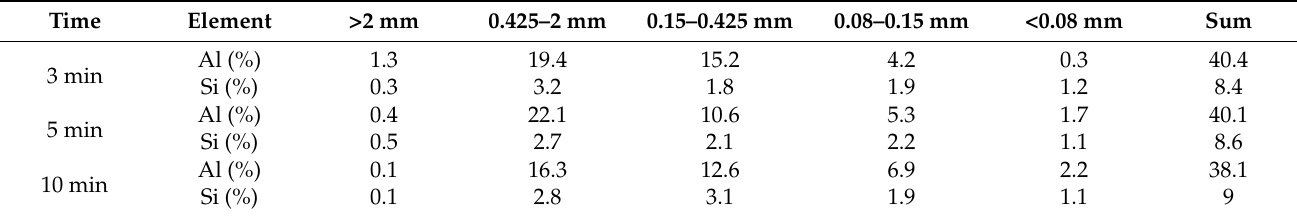
Table 2. Mass fractions of elements obtained with steel ball